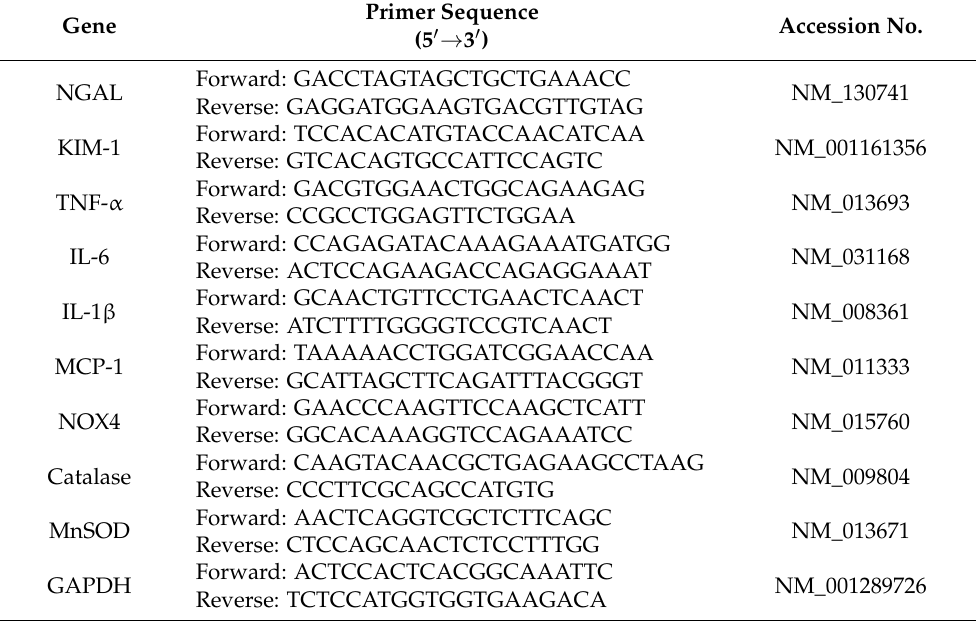
Table 1. List of